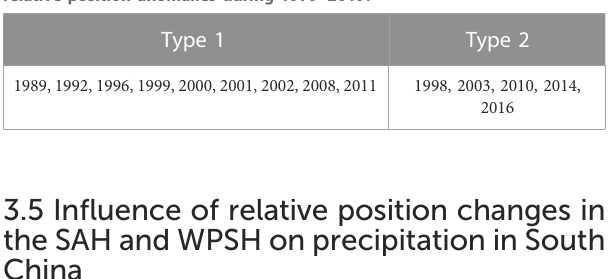
TABLE 3 Two types of years selected according to the standardized zonal relative position anomalies during 1979 – 2019.